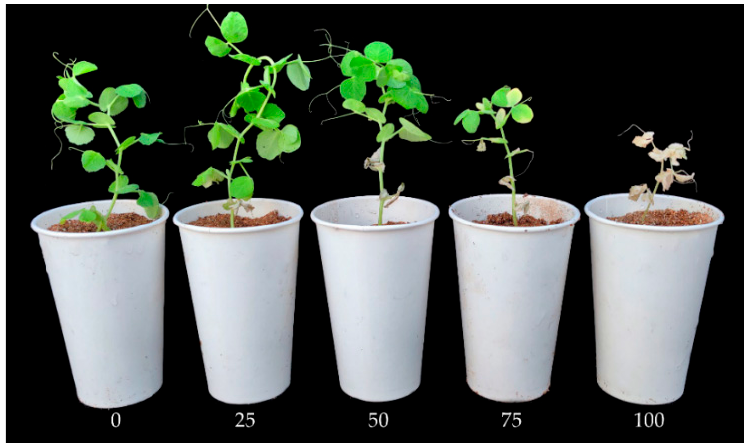
Figure 1. The estimated percentage of leaves showing symptoms for each individual plant after inoculating with the race 5 isolate PF22b of Fusarium oxysporum f. sp. pisi .